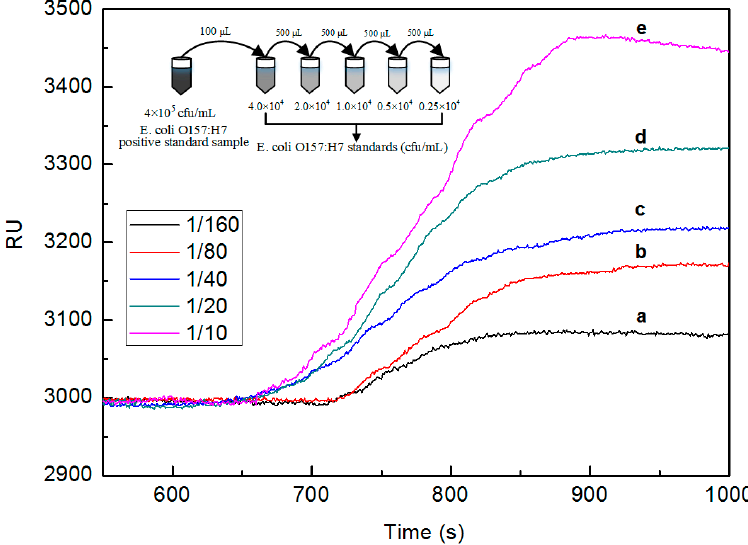
Figure 4. SPR sensorgrams generated from the detection of the positive E. coli O157:H7 sample.